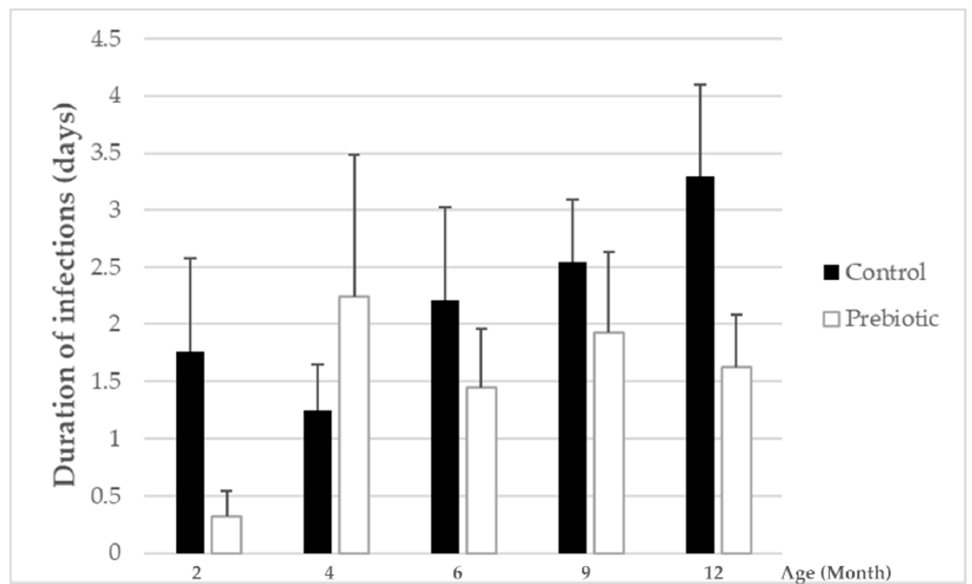
Figure 3. Mean duration of infections between the prebiotic (white bars) and control group (black bars) for months 2, 4, 6, 9 and 12. Lines represent the SEM (Standard Error of the Mean). Statistical difference between groups for total mean duration of infections was analyzed via the generalized estimating equation (GEE) approach (significantly lower with prebiotic group, p = 0.034).